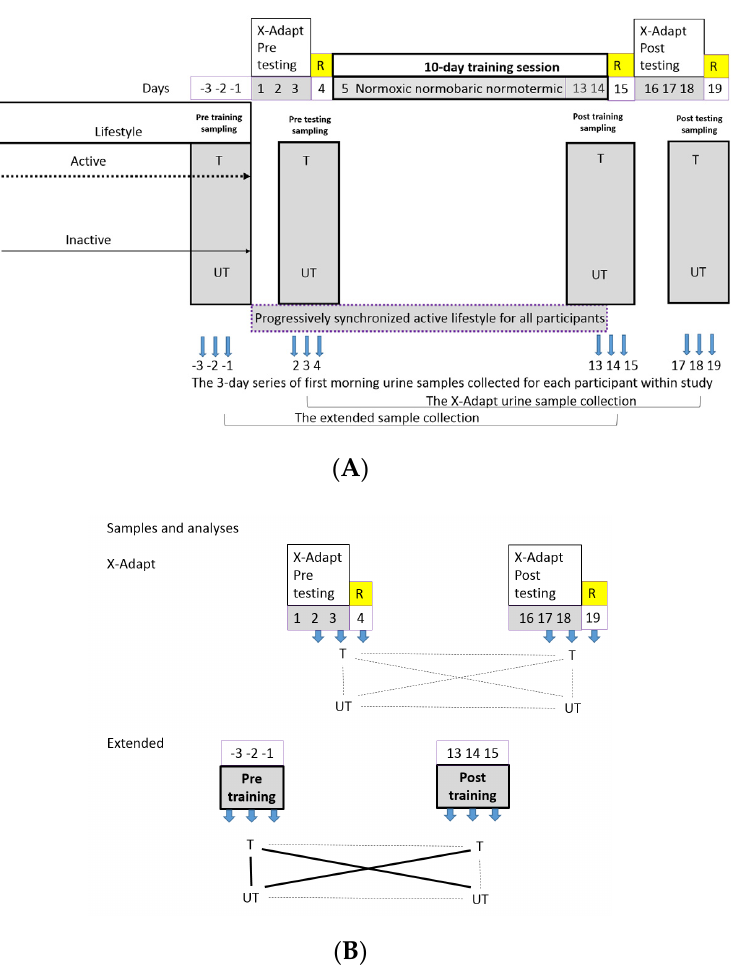
Figure 1. A schematic outline of the X ‐ Adapt project with the two sampling collections designated below: the X ‐ Adapt urine ‐ sample collection and the extended sample collection ( A ). The extended sampling was conducted at days − 3, − 2, − 1 day before the start of the campaign and at days 13, 14, 15 of the X ‐ Adapt campaign 4. T — trained; UT — untrained group of participants. Blue arrows indicate sampling days within each of the four 3 ‐ day urine ‐ sampling series. The X ‐ Adapt urine ‐ sample collection thus encompasses samples collected during the X ‐ Adapt pretesting and post ‐ testing periods. The extended sample collection encompasses the urine samples collected before the actual onset of the campaign (baseline) and during the last three days of training (days 13, 14, 15 of the campaign). For simplicity, the collection days are linked by hyphens to mark the compatible datasets. ( B ) A schematic representation of the X ‐ Adapt urine ‐ sample collection and the extended sample ‐ collection groups with their respective analyses and comparisons delineated with lines. Solid and dashed lines designate significant and not significant differences between the groups. Analyses were conducted on overall group, sample collection and daily basis